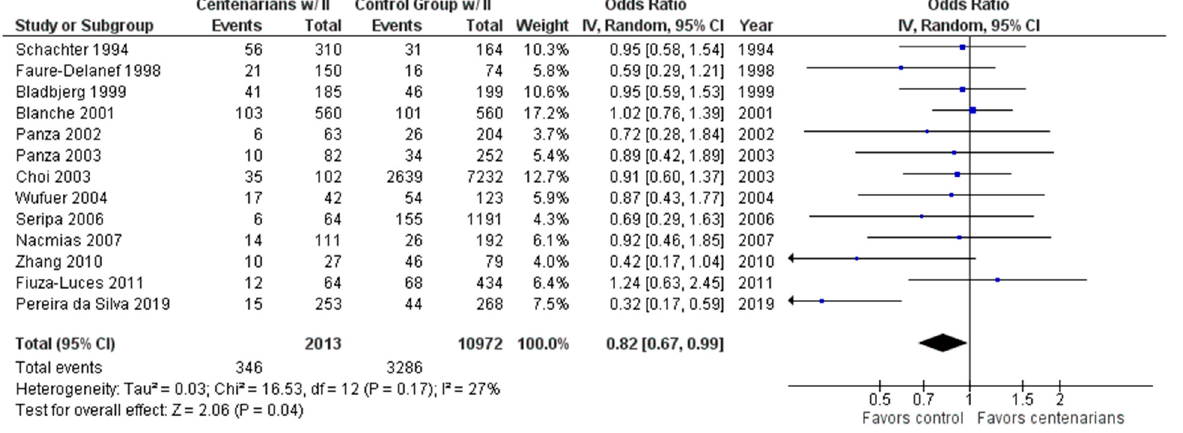
Figure 4. Comparison of II genotype frequency in centenarians and control groups. The ages of centenarians and control groups are as described in Table 1. The p -value is indicated by P in the Figure.